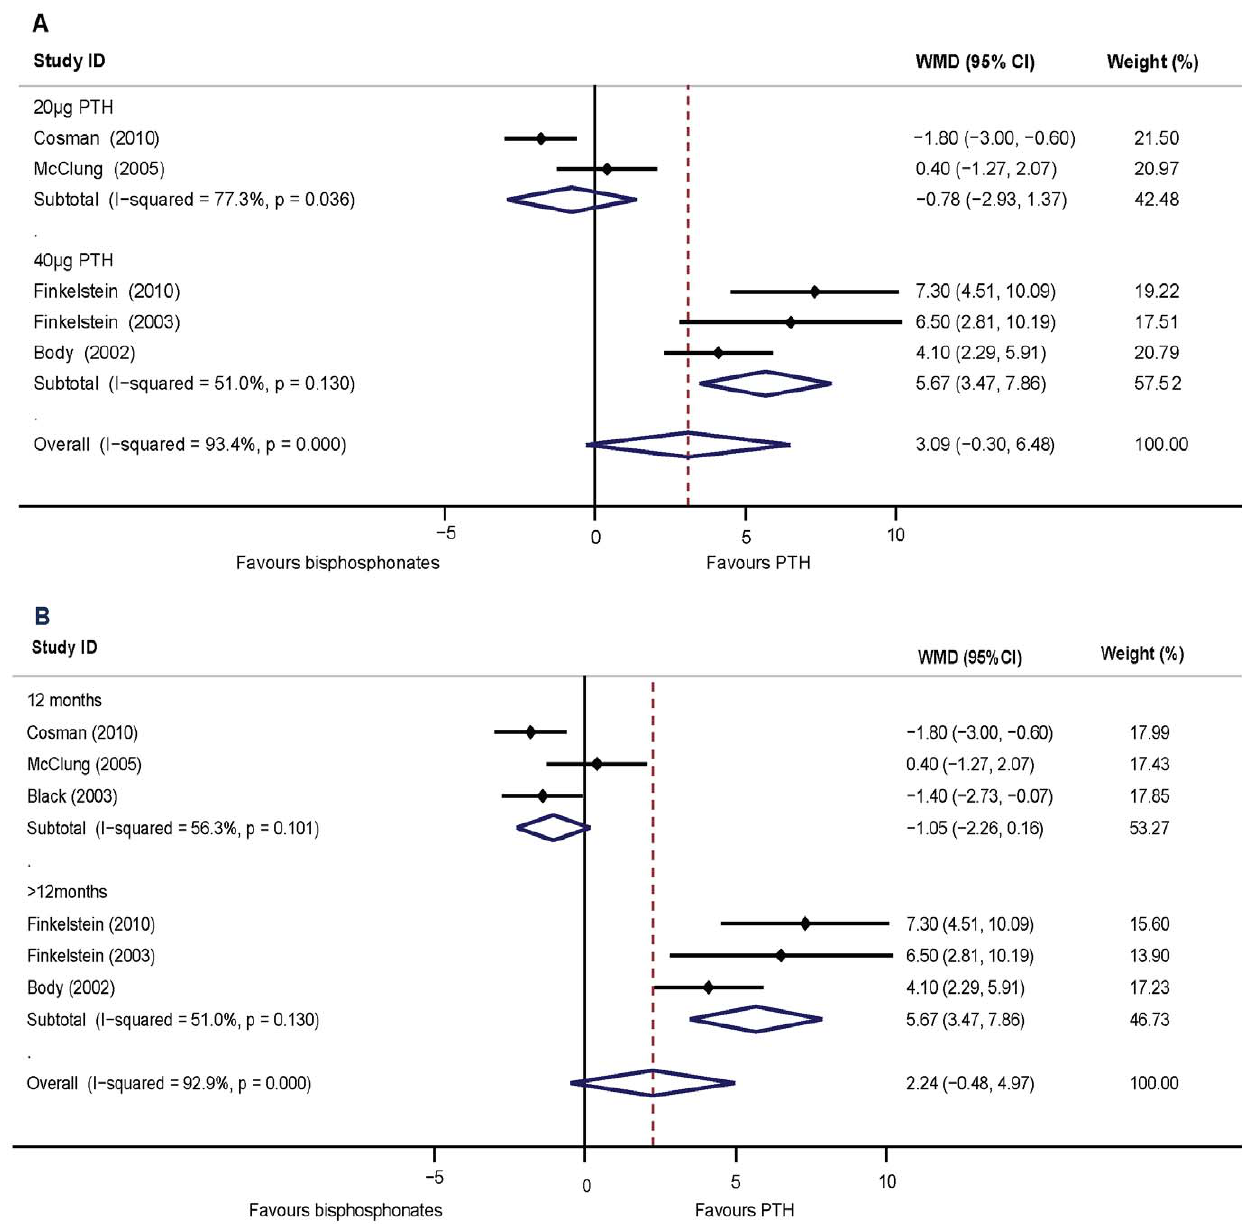
Figure 4. Assessment of the effects of PTH versus bisphosphonates on BMD of the femoral neck. A: Subgrouped analysis of the dosage of PTH (1–34) versus bisphosphonates treatment on the femoral neck BMD. B: Subgrouped analysis of the duration of PTH (1–34) versus bisphosphonates treatment on femoral neck BMD.